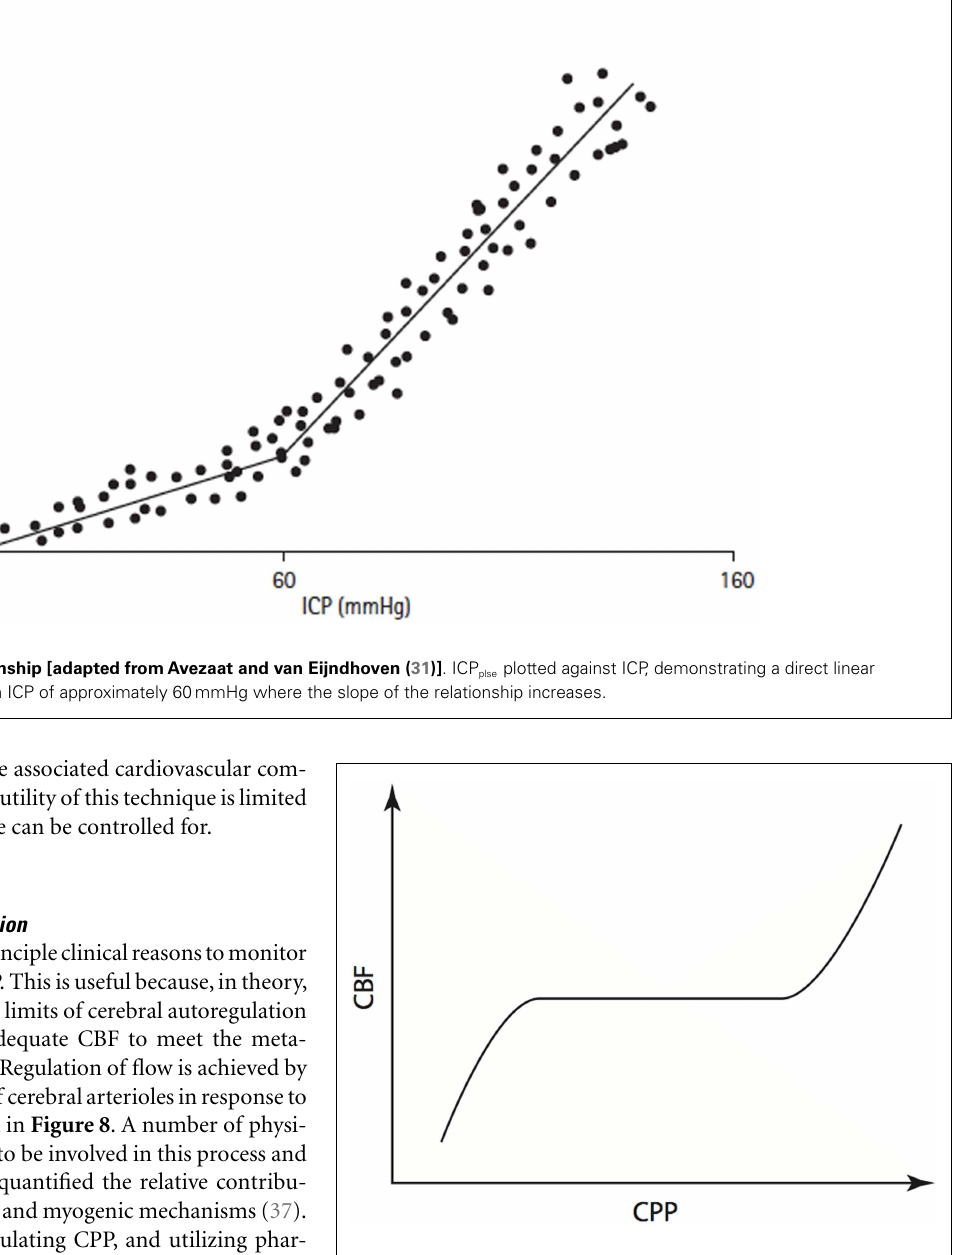
FIGURE 8 | Cerebral autoregulation . Illustration of the maintenance of cerebral blood flow across a range of cerebral perfusion